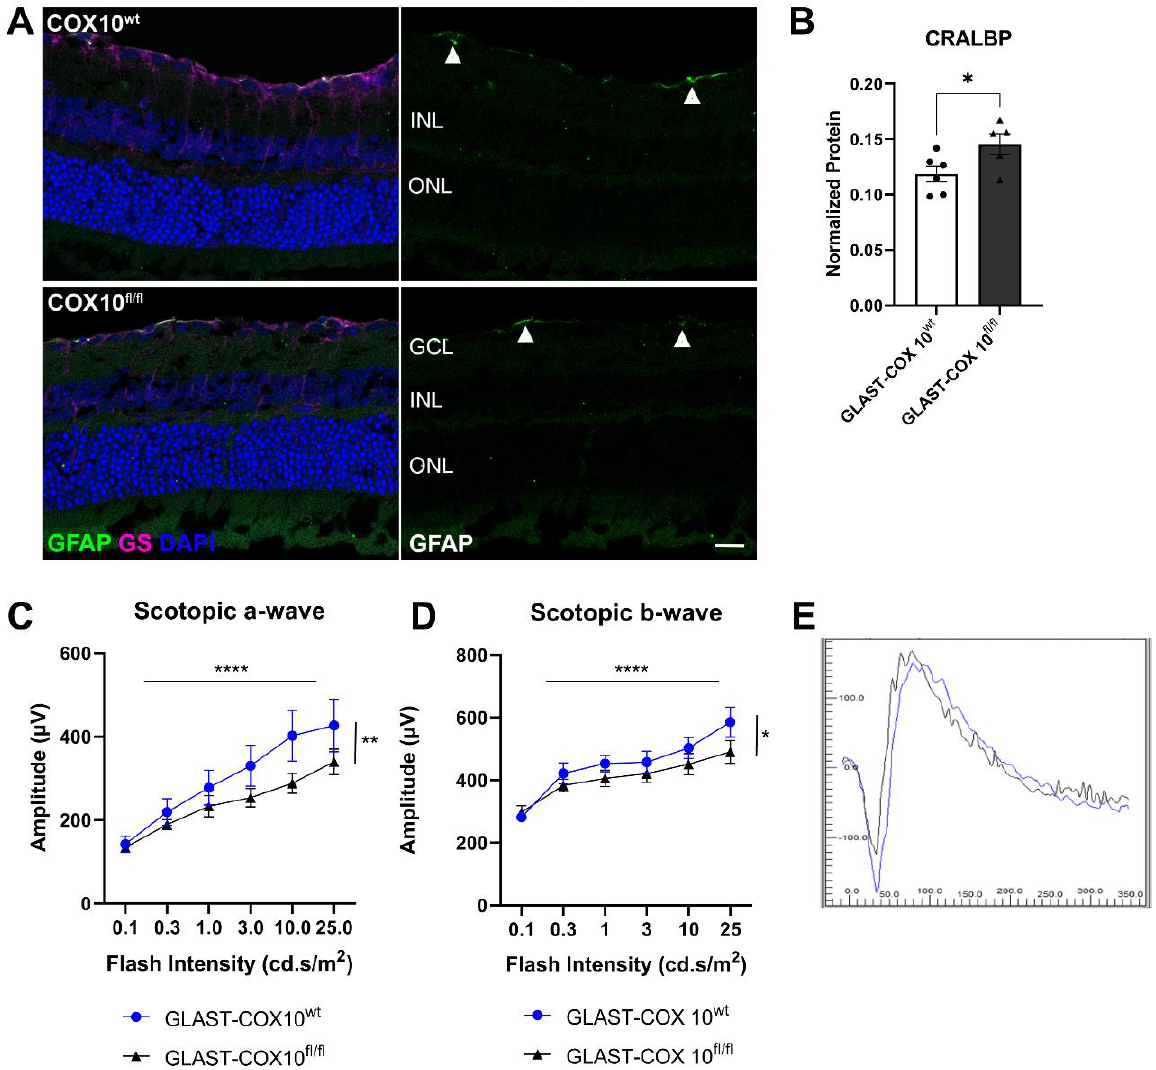
Figure 2. Selectively knocking down COX10 in MG did not induce gliosis but impacted scotopic ERG. ( A ) Immunofluorescence images showing GFAP (green) and glutamine synthetase (magenta) localization in retina cross-sections from 3-month-old mice from control and GLAST-COX10 fl/fl retinas. There was limited expression of GFAP in the nerve fiber layer, which likely corresponds to astrocytes (white arrowheads). GCL = ganglion cell layer; INL = inner nuclear layer; ONL = outer nuclear layer. ( B ) Capillary electrophoresis of wildtype and GLAST-COX10 fl/fl mouse retina shows an increase in the CRALBP protein in the conditional knockout mice (* p = 0.0459). Error bars repre- sent mean ± SEM. ( C ) Knocking down COX10 in MG significantly reduced a-wave amplitude (two- way ANOVA; simple main effects for genotype (F(1,72) =7.946; ** p = 0.0062) and light intensity (F(5,72) =12.05; **** p < 0.0001)). Error bars represent mean ± SEM. ( D ) Knocking down COX10 in MG also significantly reduced the b wave amplitude. Two-way ANOVA to analyze the effect of genotype and light intensity on scotopic b-wave amplitude revealed that there were was not a sta- tistically significant interaction between the effects of genotype and light intensity (F(5,72) = 0.67; p = 0.64). Simple main effects analysis showed that genotype (F(1,72) =5.65; * p = 0.02) and light inten- sity (F(5,72) =14.43; **** p < 0.0001) each had statistically significant effects on scotopic b-wave am- plitude. Error bars represent mean ± SEM; N = 6/group. ( E ) Representative traces for scotopic ERG for wildtype and GLAST-COX10 fl/fl mice 8 weeks after tamoxifen injection. GCL = ganglion cell layer; INL = inner nuclear layer; ONL = outer nuclear layer. Scale bar: 25 µm. 3.3. Oxidative Stress and MG Homeostasis Oxidative stress depends on the balance of antioxidant synthesis and reactive oxygen species generation and can be determined by examining oxidative modifications of pro- tein, DNA, and lipids. Immunolabeling for 3-nitrotyrosine (3NT), a marker for protein nitrosylation, shows greater 3NT label in the IPL of GLAST-COX10 fl/fl retina, and a shift of